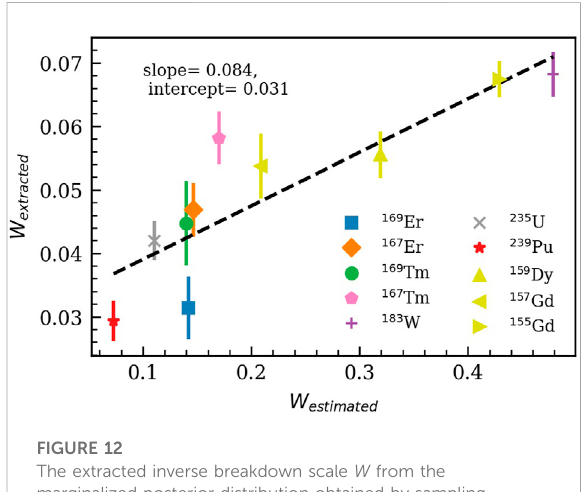
FIGURE 12 The extracted inverse breakdown scale W from the marginalized posterior distribution obtained by sampling compared to its naively expected size. The expected size is taken to be the maximum of E rot / E sp and E rot / E vib . The dashed black line shows the best linear fi t and its parameters are printed on the plot. The yellow colored symbols are results for rotational bands with bandheads K =3/2, all the others are K =1/2 bands. 99 Tc is an outlier and we exclude it from the plot (its values can be seen in Table